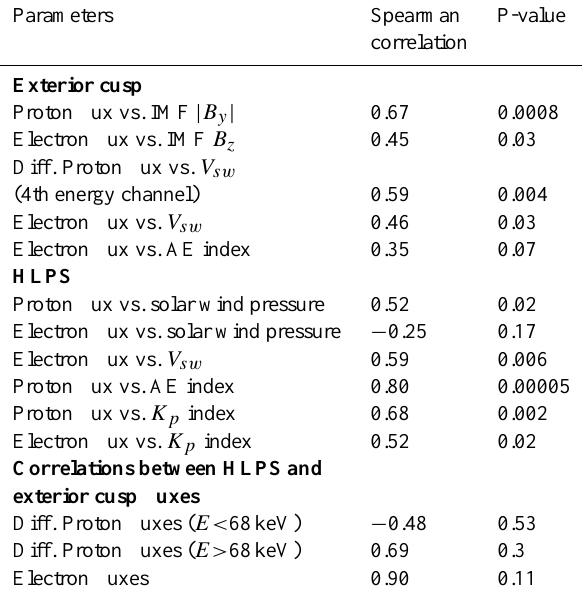
Table 5. Summary of different correlation coefficients and their